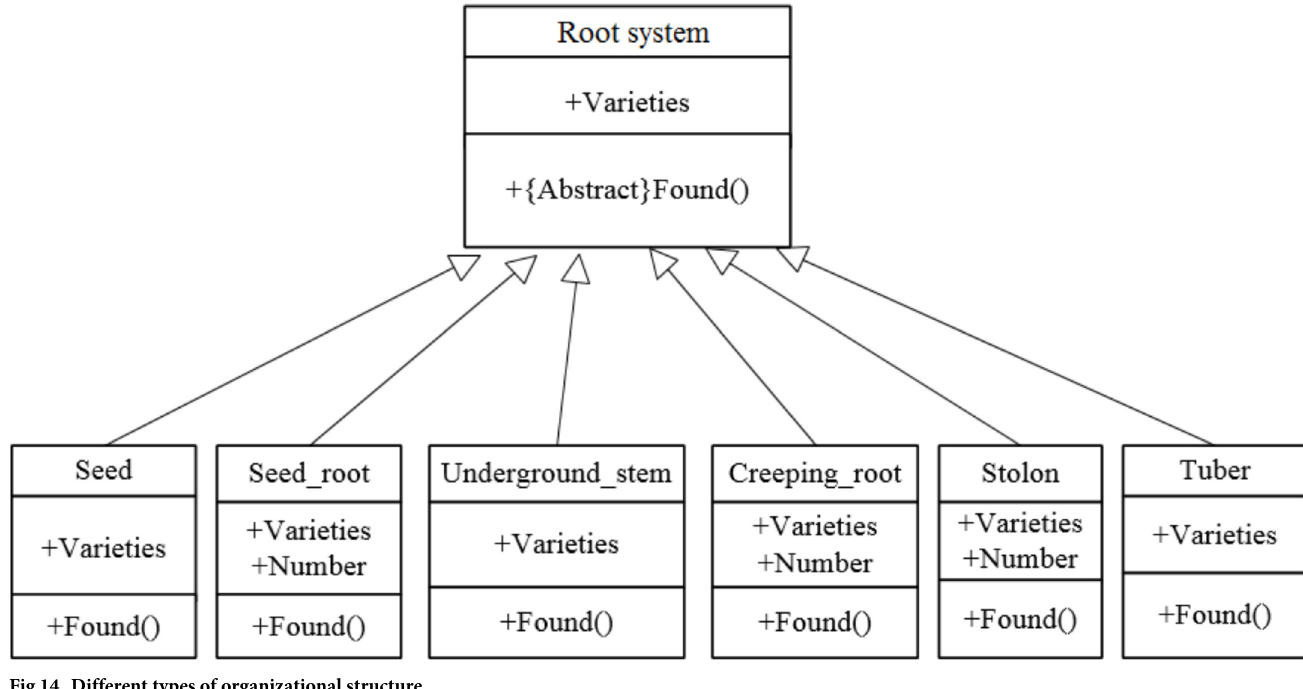
Fig 14. Different types of organizational